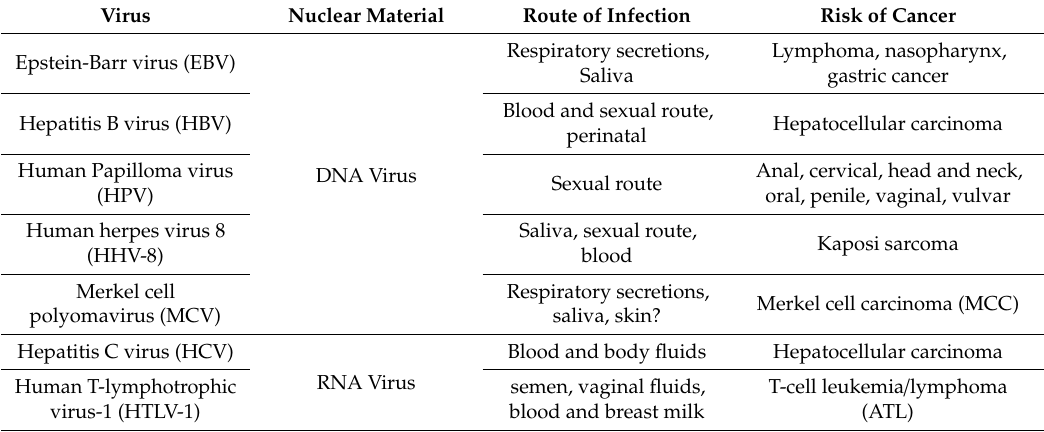
Table 1. List of human viruses that possess potential threats for malignant